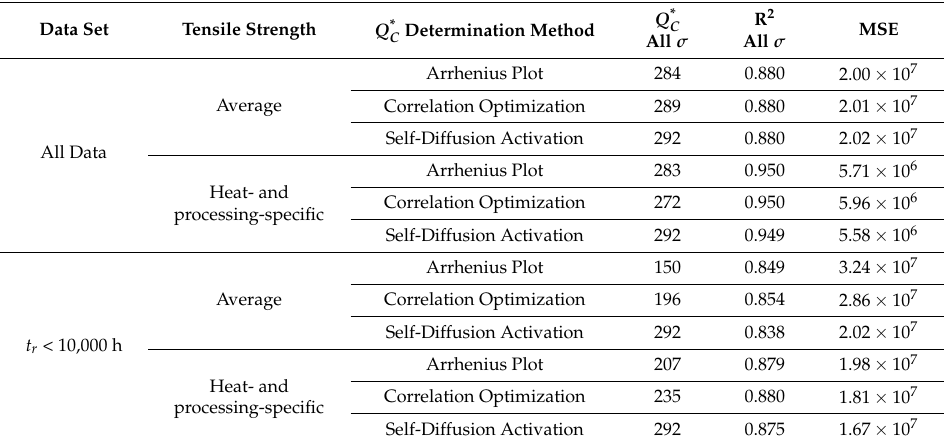
Table 6. Quality of fit and error for Nimonic